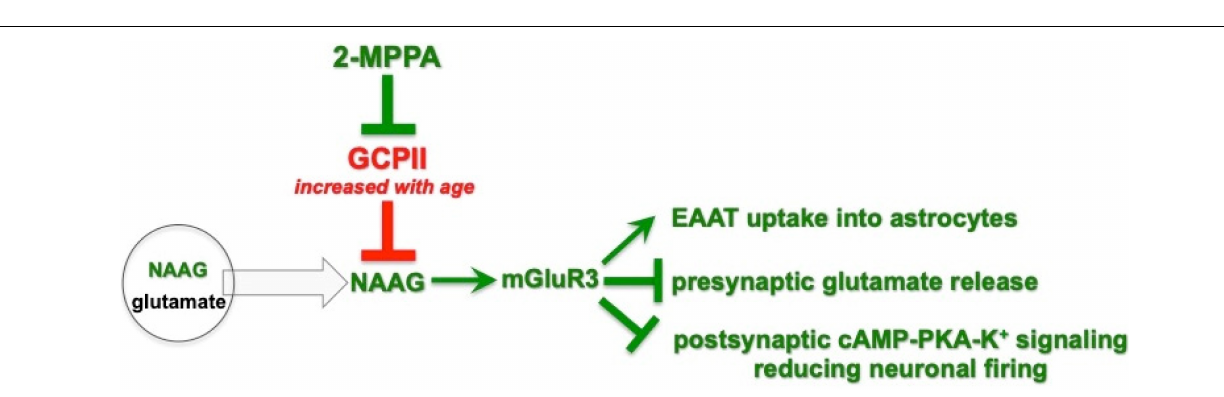
FIGURE 6 | Administration of the GCPII inhibitor, 2-MPPA, improves performance on the delayed alternation test of spatial working memory. (A) The effects of oral administration of 2-MPPA on working memory performance in young adult rats ( n = 9). (B) The effects of oral administration of 2-MPPA on working memory performance in aged ( n = 11) rats. 2-MPPA produced significant, dose-related improvements in percent correct on the spatial delayed alternation task in a T maze in both age groups (see text). (C) Infusion of 2-MPPA directly into the adult rat PFC ( n = 8) significantly improved working memory performance. Results are expressed as the mean ± SEM.